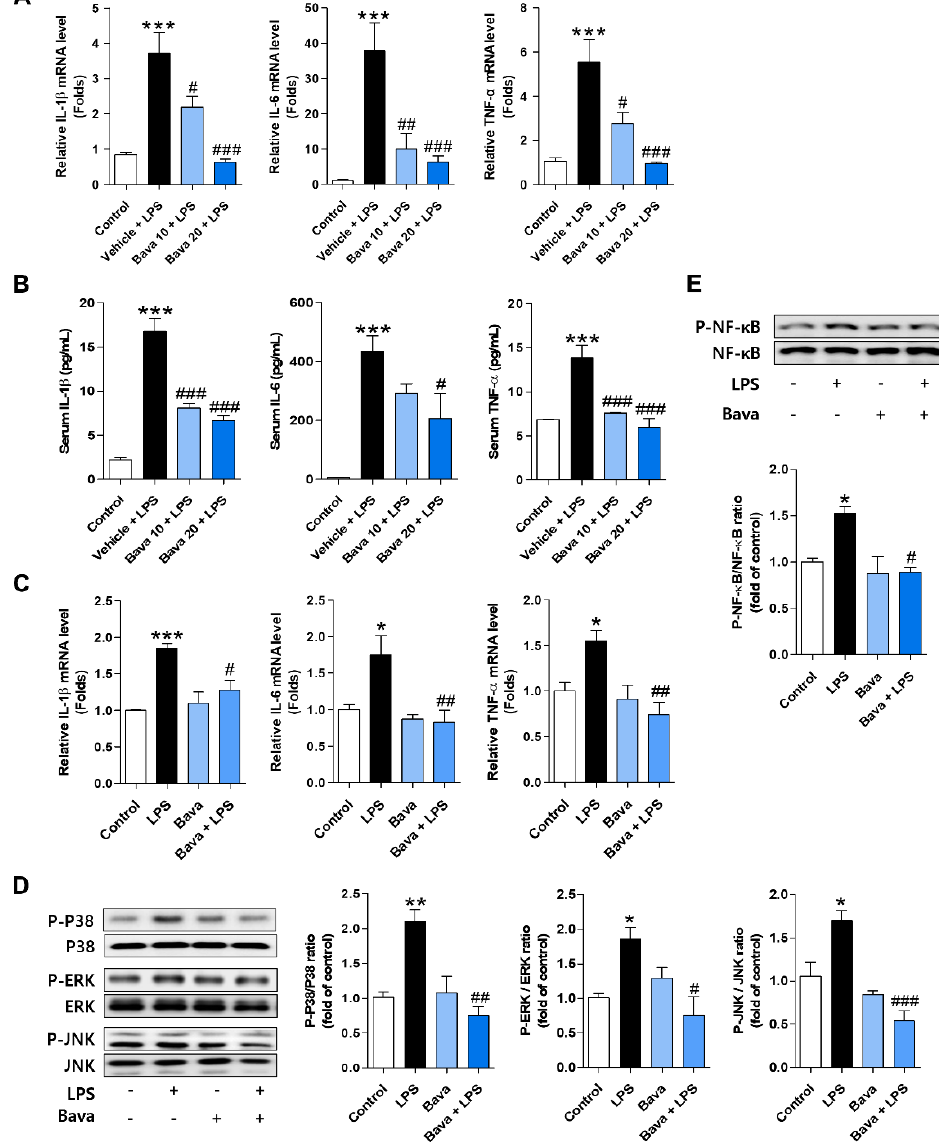
Figure 5. Bavachin decreases the expression of inflammatory cytokines by downregulating the MAPK/NF- κB pathway in LPS -induced AKI mice and LPS-treated HK-2 cells. ( A ) The mRNA levels of interleukin (IL)- 1β, IL -6, and tumor necrosis factor- α (TNF - α) in kidney tissues were analyzed by qRT-PCR ( n = 5 mice per group). ( B ) Protein levels of IL- 1β, IL -6, and TNF- α in serum were analyzed by ELISA ( n = 5 mice per group). ( C ) HK- 2 cells were pretreated with 0.1 μg/mL bavachin for 1 h and then treated with LPS for 15 h. The mRNA levels of IL- 1β, IL -6, and TNF- α were analyzed using qRT-PCR ( n = 4). ( D , E ) HK- 2 cells were pretreated with 0.1 μg/mL bavachin for 1 h and then treated with 1 μg/mL LPS for 1.5 h. ( D ) The protein levels of phospho (P)-P38 (P-P38), P-ERK, P-JNK MAP kinase, and ( E ) phospho-nuclear factor kappa B (P-NF- κB) were analyzed by Western blotting; quantified using ImageJ software; and normalized to P38, ERK, JNK, and NF- κB, respectively ( n = 3). Data are presented as mean ± SEM. * p < 0.05, ** p < 0.01, *** p < 0.005 vs. control; # p < 0.05, ## p < 0.01, ### p < 0.005 vs. vehicle + LPS or LPS. 3.6. Bavachin Decreases NF- κB Signaling via Down-Regulation of KLF5 in LPS-Induced AKI Mice and LPS-Treated HK-2 Cells The transcription factor KLF5 has been identified in the kidney and has been reported to regulate pathological conditions in various kidney cells [28]. As the role of KLF5 in the septic AKI model is unknown, we examined its involvement in the LPS-induced AKI